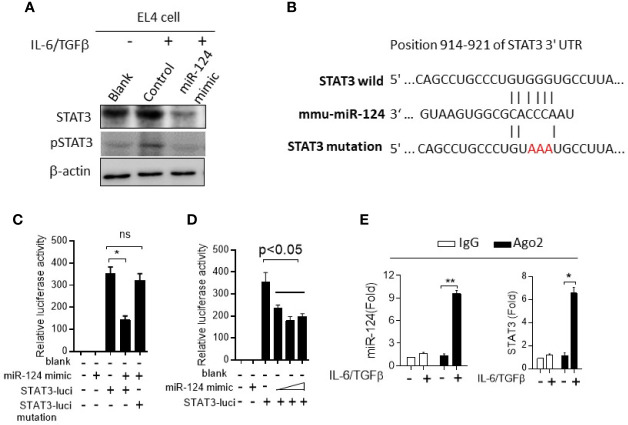
STAT3 is the target of miR-124. (A) EL4 cells were primed with IL-6 and TGFb in the presence of miR-124 mimic. STAT3 protein level was evaluated by western blotting. (B) Schematic representation of wild-type (wt) and mutant (mut) STAT3 3′UTR luciferase reporter constructs of predicted miR-124 target gene. The miR-124 binding region is indicated. (C) EL4 cells were co-transfected with miR-124 mimic and STAT3 3′UTR luciferase reporter plasmid after priming with IL-6 and TGFβ. (D) 293 T cells were co-transfected with either WT or mutant STAT3 luciferase reporter plasmids together the miR-124 mimic for 48 h. The cell lysates were prepared and luciferase activity was determined (Data represent mean ± s.d.). (E) EL4 cells were primed with IL-6 and TGFb in the presence of miR-124 mimic for 24 h. Total RNA was extracted and immunoprecipitated with anti-Ago2 antibody. The immunoprecipitated RNA was purified, and qPCR was performed for the analysis of miR-124 and STAT3 mRNA expression (Data represent mean ± s.d.). The results are representative of three independent experiments (Data represent mean ± s.d.). The results are representative of two independent experiments. *p < 0.05, **p < 0.01; ns indictated the negative significance.